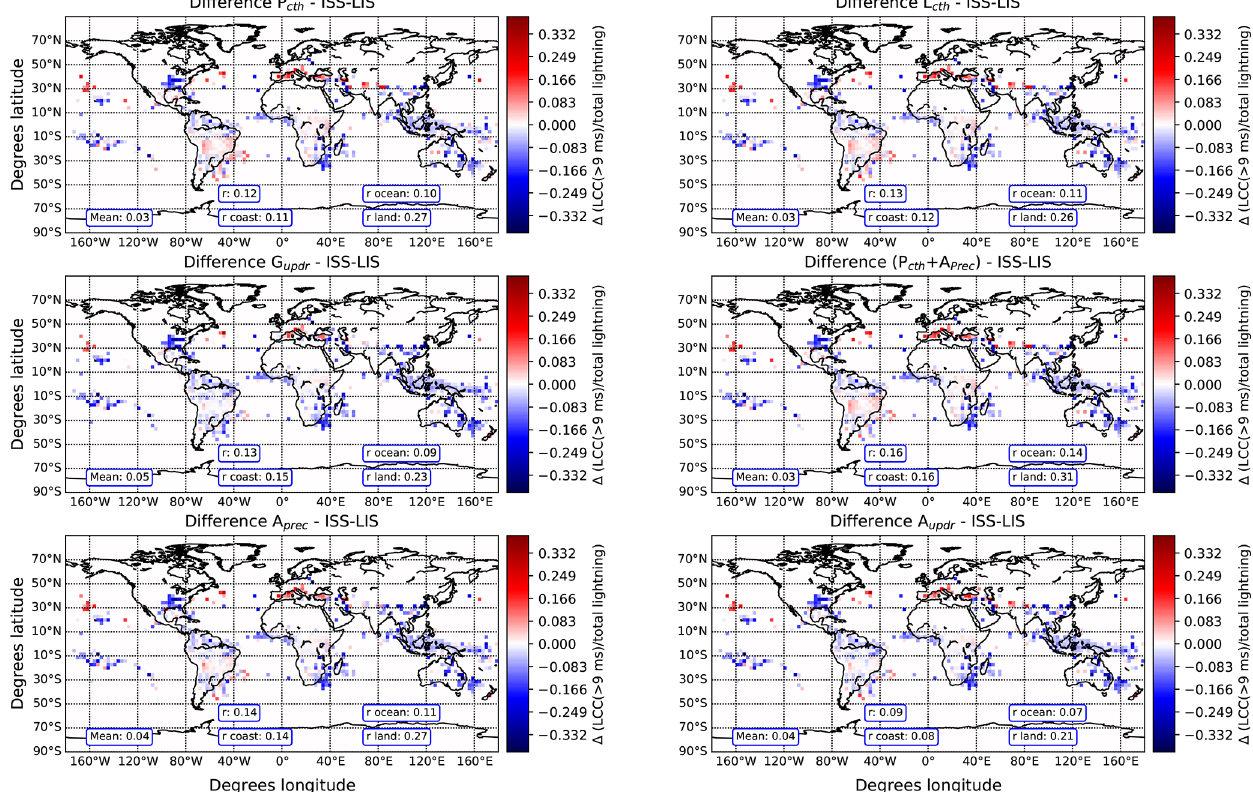
Figure 9. Difference between the observed and simulated ratio of LCC( > 9ms) lightning to total lightning density in December, January, and February using different lightning parameterizations. Positive values indicate that the model overestimates the ratio. The calculated global, land, and ocean spatial correlation coefficients r are